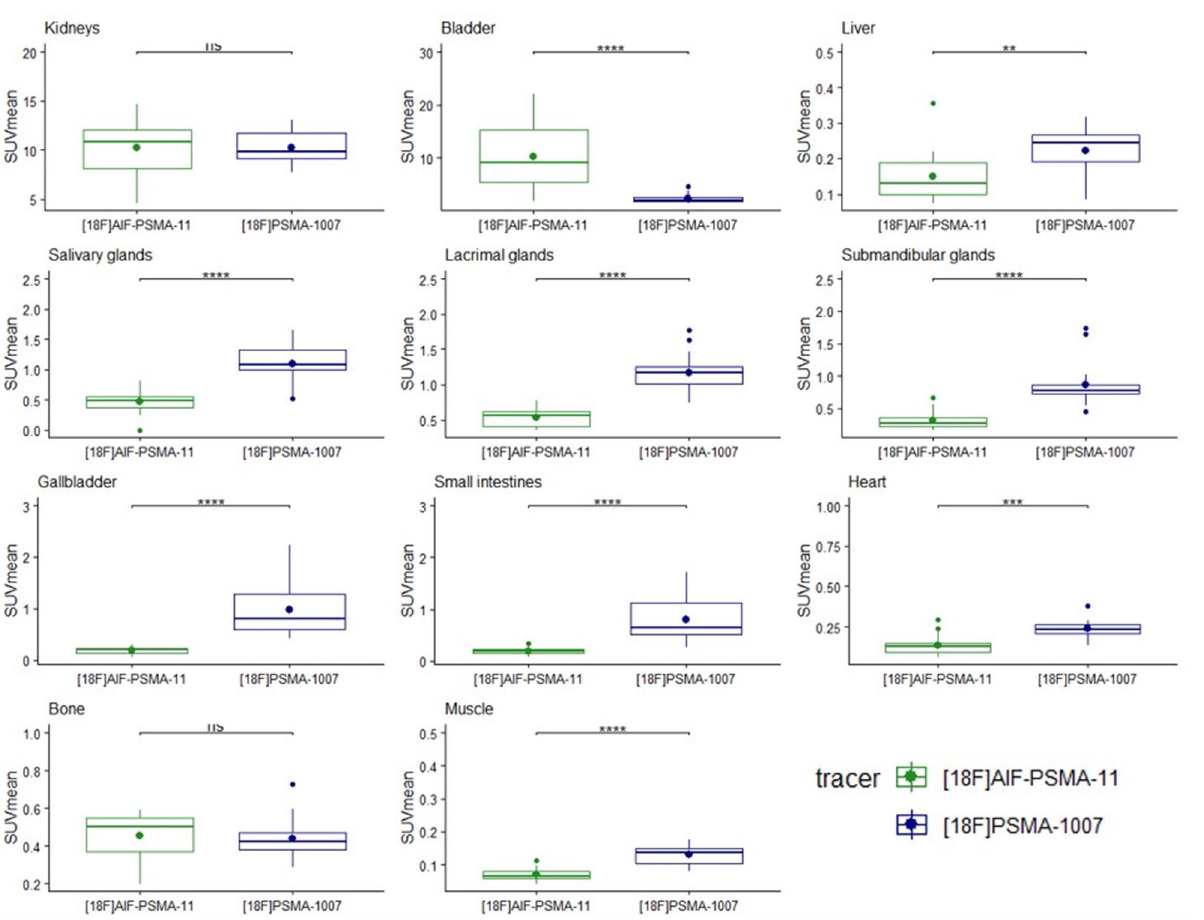
Figure 4. SUV mean for [ 18 F]AlF-PSMA-11 and [ 18 F]PSMA-1007 uptake in healthy organs: kidneys, bladder, liver, salivary glands, lacrimal glands, submandibular glands, gallbladder, small intestines, heart and bone. The dot presents the mean, the horizontal bar presents the median value. Ns = not significant, * = p < 0.05, ** = p < 0.01, *** = p < 0.001, **** = p <